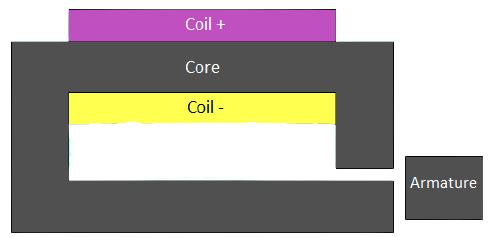
Figure 19. Initial geometry of the